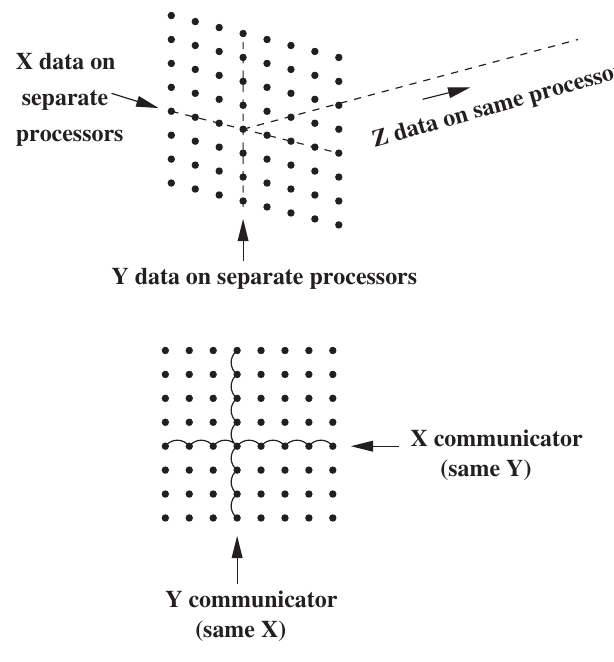
FIG. 2. Definition of two communication groups, one in X and one in Y .